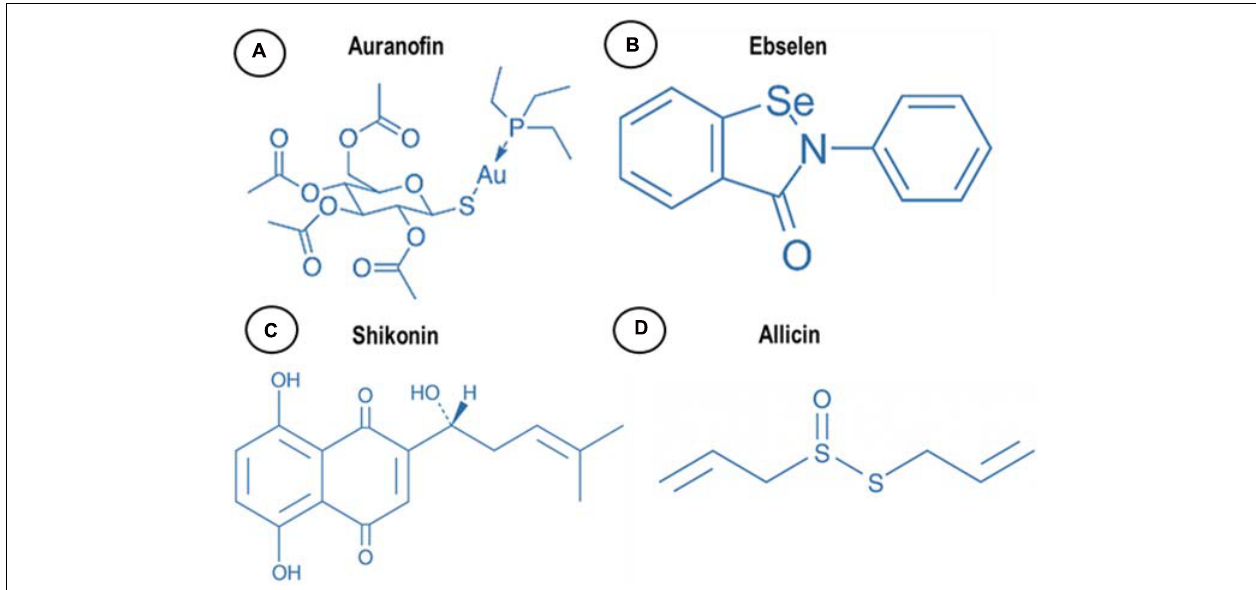
FIGURE 2 | Chemical structure of (A) auranofin, (B) ebselen, (C) shikonin, and (D) allicin.